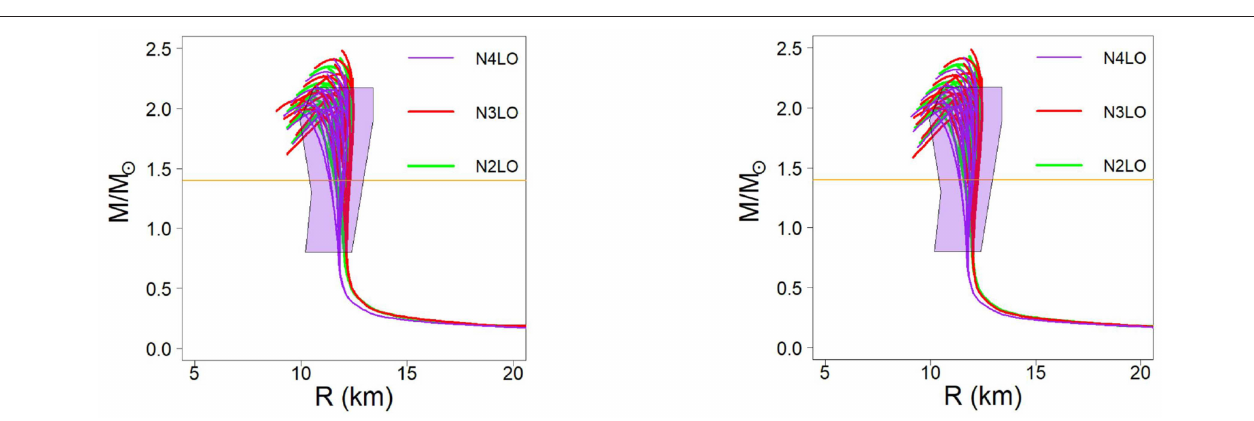
FIGURE 13 | The mass vs. radius relation at the given chiral order. (Left) 3 =450 MeV; (Right) 3 =500 MeV. The purple curves are the result of extending the predictions at N 4 LO, while the red and the green curves are obtained extrapolating the predictions at N 3 LO and at N 2 LO, respectively. The horizontal yellow lines marks the value of 1.4 M ⊙ . The shaded area in the background is the constraint taken from Steiner et al. [ 159].